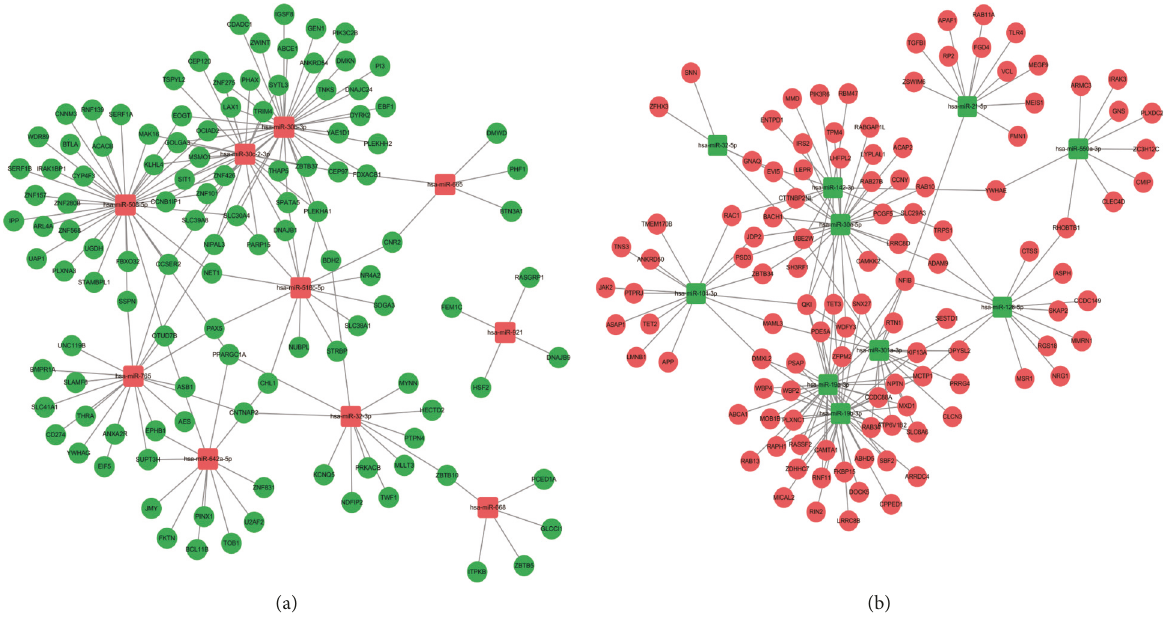
Figure 2: miRNA target prediction and selection. The target prediction of each miRNA was conducted using miRDB, TargetScan, miRWalk, and miRTarBase databases. (a) The target genes of upregulated DEmis commonly predicted by 3 and 4 databases and simultaneously overlapped with the downregulated DEGs from the GSE100054 dataset were selected to construct the regulatory network. (b) The regulatory network of downregulated DEmis and their target genes selected from overlaps between upregulated DEGs from GSE100054 dataset and predicted targets by 3 and 4